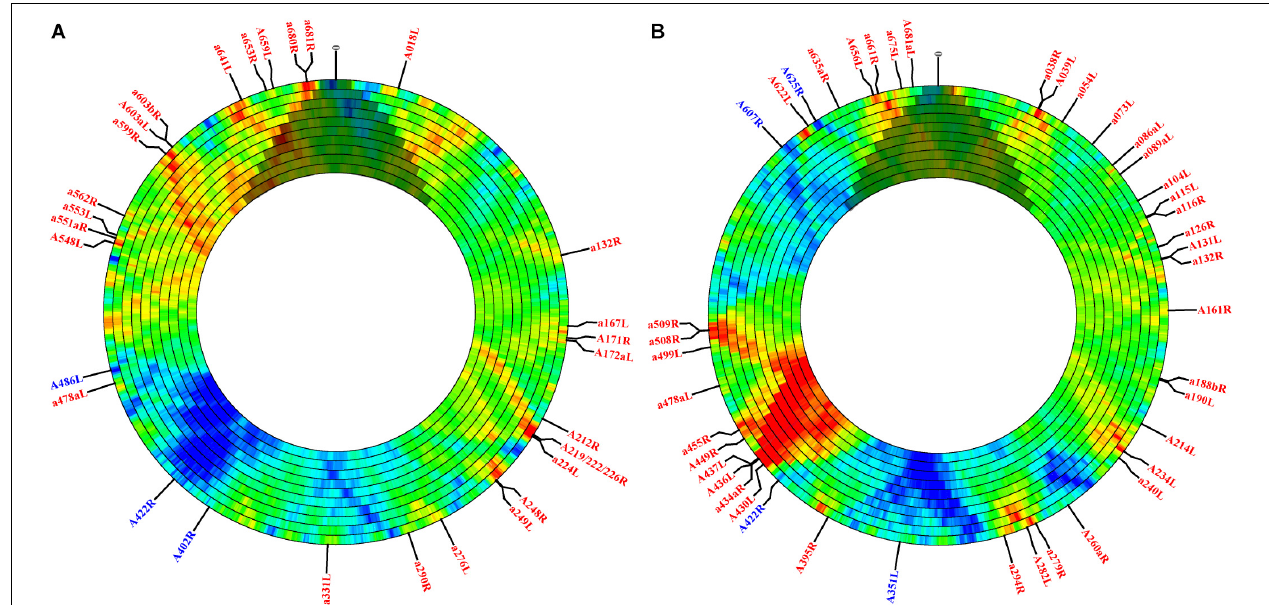
FIGURE 1 | PBCV-1 motif enrichment and depletion determined in the context of local codon flexibility at different genomic increments. The PBCV-1 genome was analyzed for motif frequency of CATG (A) and GATC (B) tetramers. Panels show increasing window sizes, ranging from 4 to 40 kb moving from the outer to inner ring. Each ring increases incrementally by 4 kb, but the step size is always 4 kb. The Z-score is represented with color; red indicates more enriched scores and blue indicates more depleted scores. Green represents the expected frequency with no depletion or enrichment. Since the DistAMo software was created for circular chromosomes, there is artificial data coded across the termini (at 12 o’clock) for the linear PBCV-1 genome. This region has been shaded over to discourage faulty interpretation. Genes with significant Z-scores (greater than the absolute value of 2) are annotated by color (blue is enriched and red is depleted) and are included in Supplementary Table S2 . Finally, the polycistronic region containing the viral tRNAs are not annotated in the DistAMo graphs since they are not annotated as genes at NCBI, though they are known to lie at the center of the genome between annotated genes A326L and